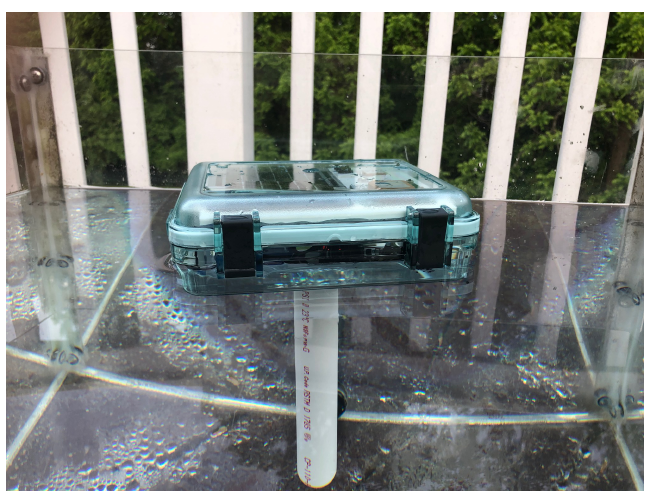
Figure 2. A drifting Maker Buoy without the protective sleeve floating in an aquarium during testing. The PVC stabilizer is visible underwater.